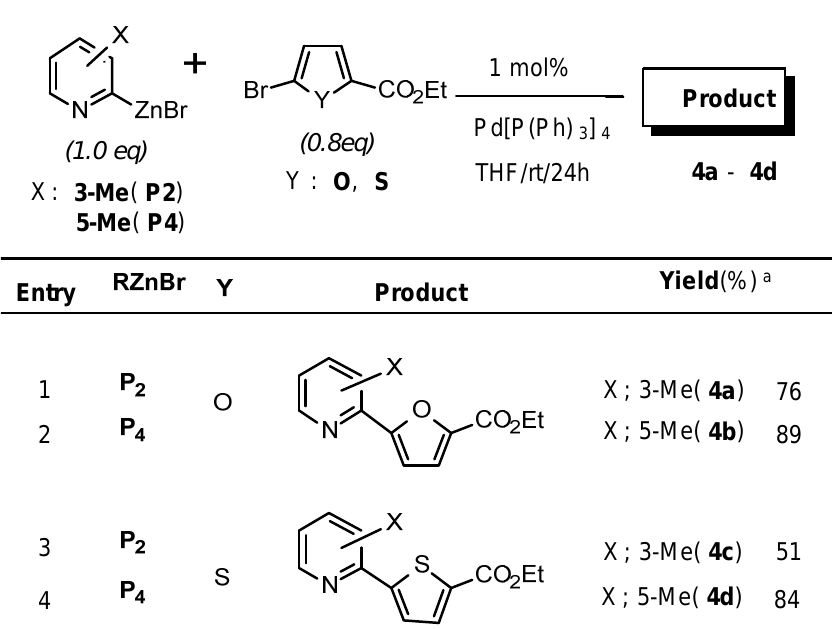
Table 4. Steric effect on cross-coupling